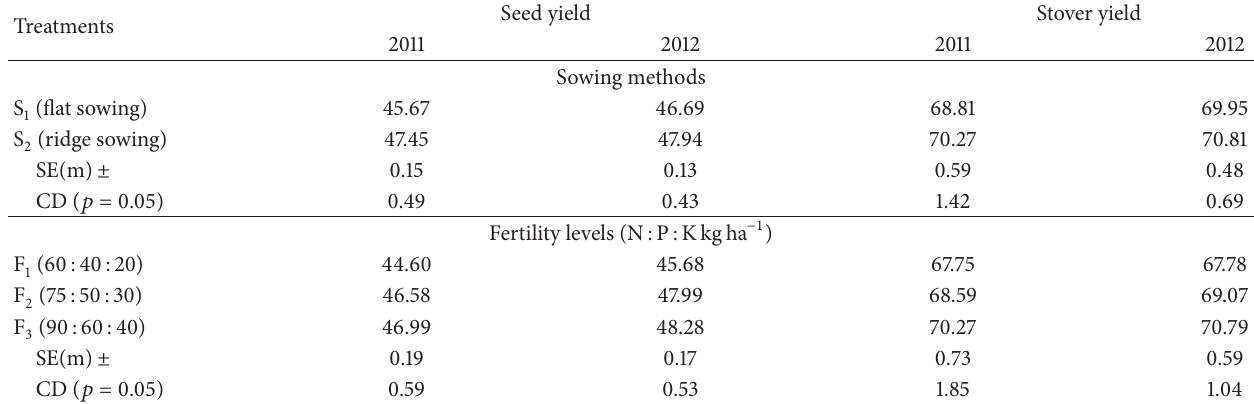
Table 3: Seed and stover yield (qha − 1 ) of maize as affected by sowing methods and NPK levels. Seed Treatments